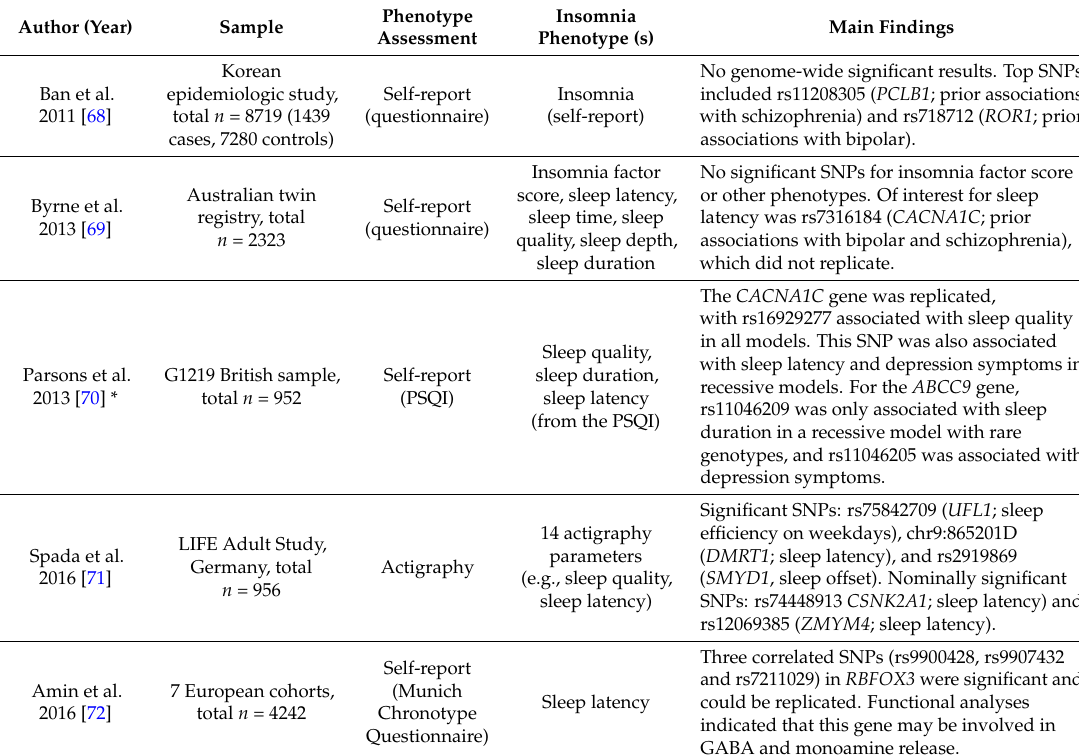
Table 3. Genome-wide association studies (GWAS) of insomnia